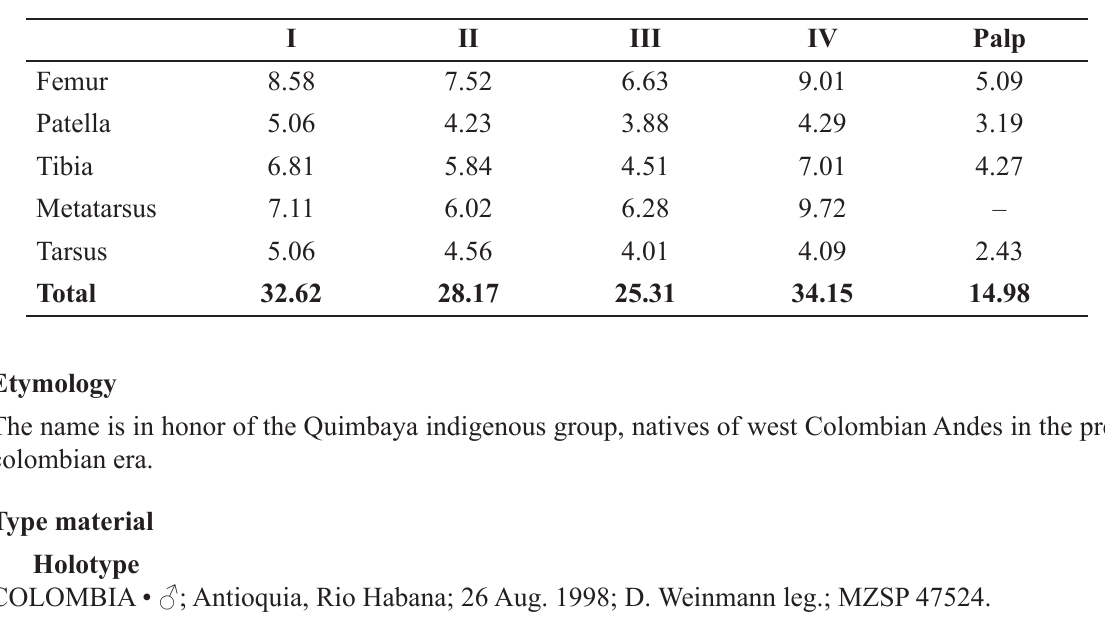
Table 5. Length of legs and palpal segments of holotype, ♂ (MZSP 47524) of Schismatothele quimbaya sp.